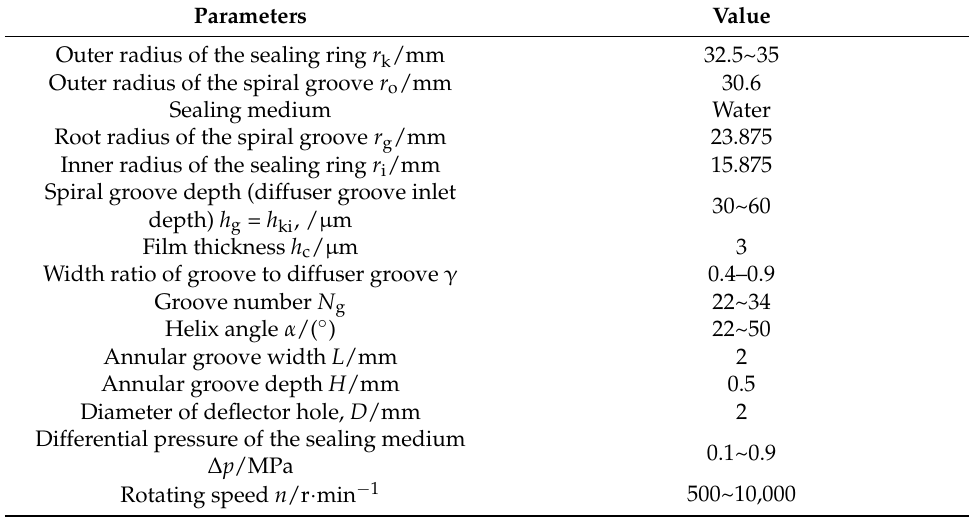
Table 2. Boundary condition